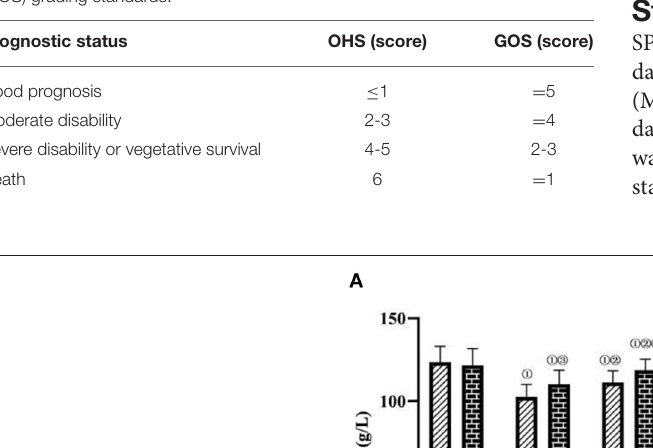
› P < 0.05; compared with the control group